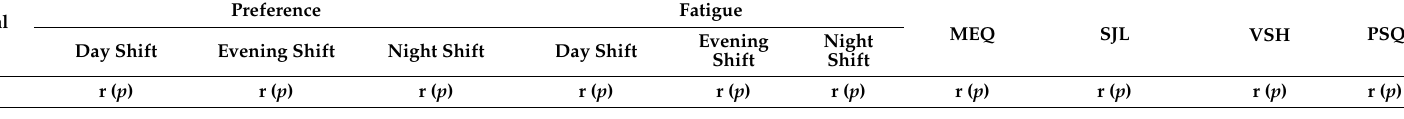
Table 3. Correlation between work-related characteristics, chronotype, social jetlag (SJL), and sleep quality ( n =